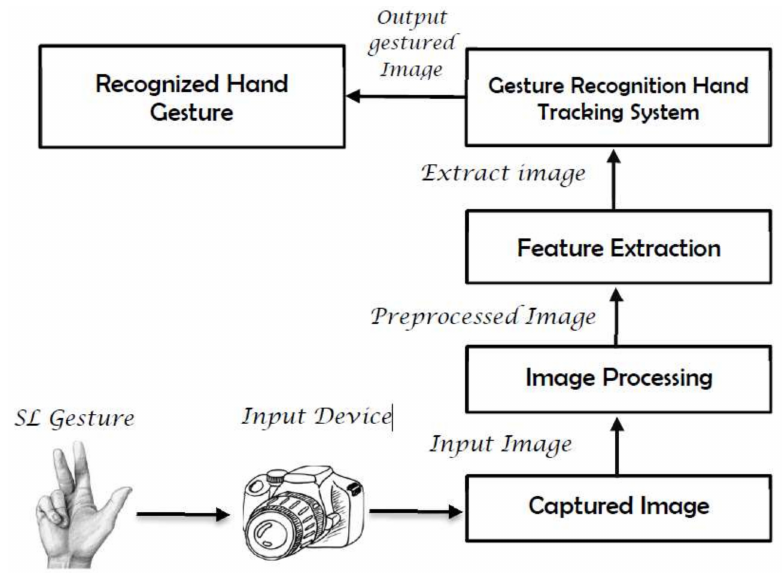
Figure 3. A flow chart of the processing steps used in the vision-based system for SLR.